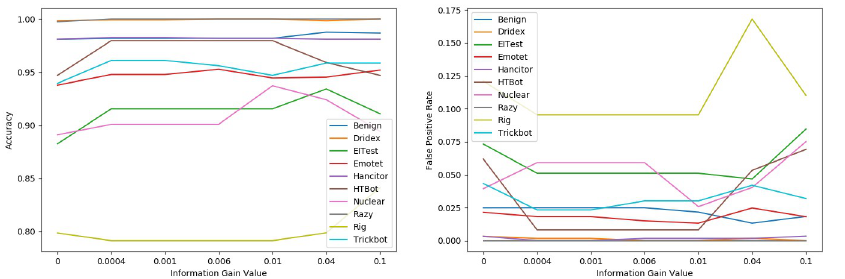
Fig 7. Classification results from 10 binary classifiers among different feature